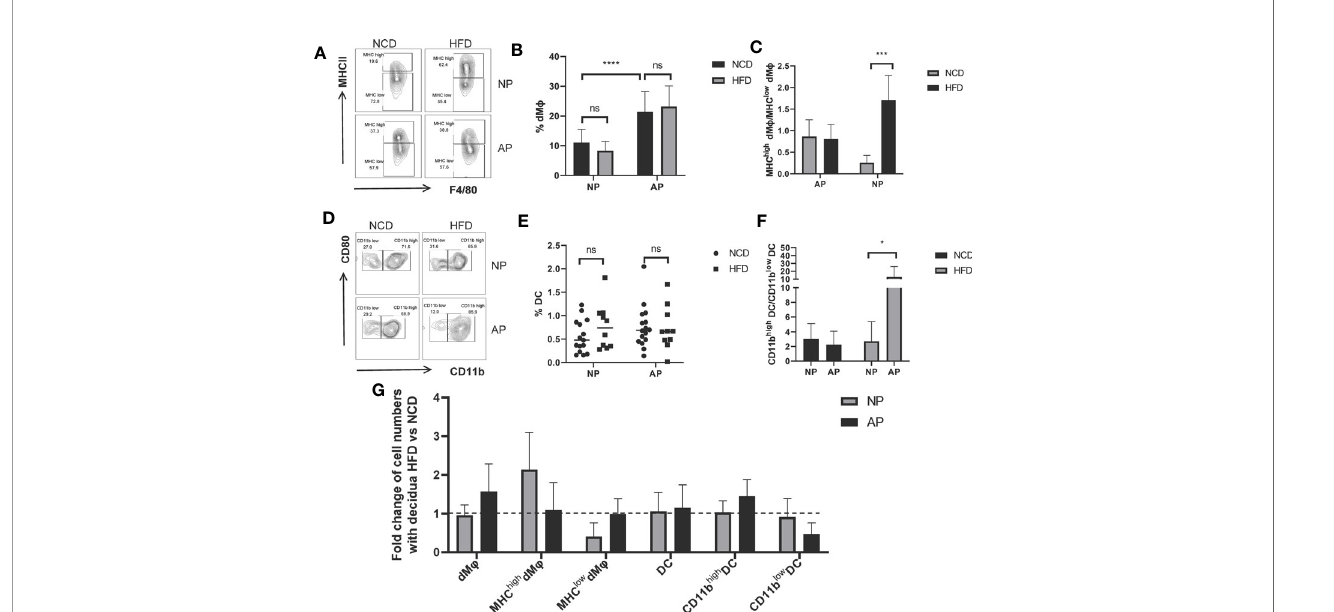
FIGURE 3 | Different responses of myeloid cells to maternal obesity challenge in NP and AP models. (A) Representative fl ow cytometric analysis of macrophages isolated from deciduas stained with MHC-II and F4/80 fl uorochrome-conjugated antibodies. (B) Total numbers of decidual macrophages. (C) Ratios of MHC-II high versus MHC-II low macrophage subsets in deciduas. (D) Representative fl ow cytometry analysis of DCs within pregnant uteri marked with CD80 and CD11b fl uorochrome-conjugated antibodies. (E) Total numbers of decidual DCs. (F) Ratios of CD11b high versus CD11b low DC subsets in deciduas. (G) Summary of fold changes in decidual myeloid immune cell numbers under obesity challenge in NP and AP models. Data are presented as mean ± SEM. NS, not signi fi cant; *p < 0.05, ***p < 0.001, ****p <